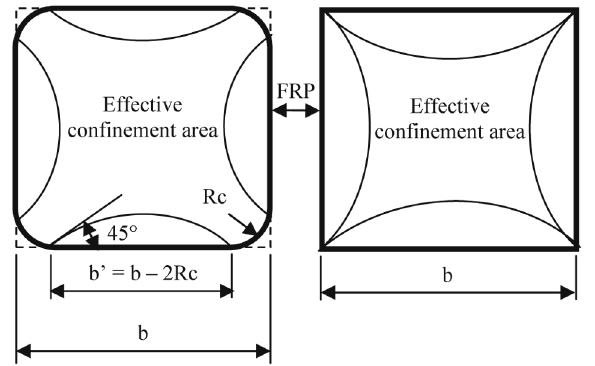
Fig. 16. Effectively confined core for square sections